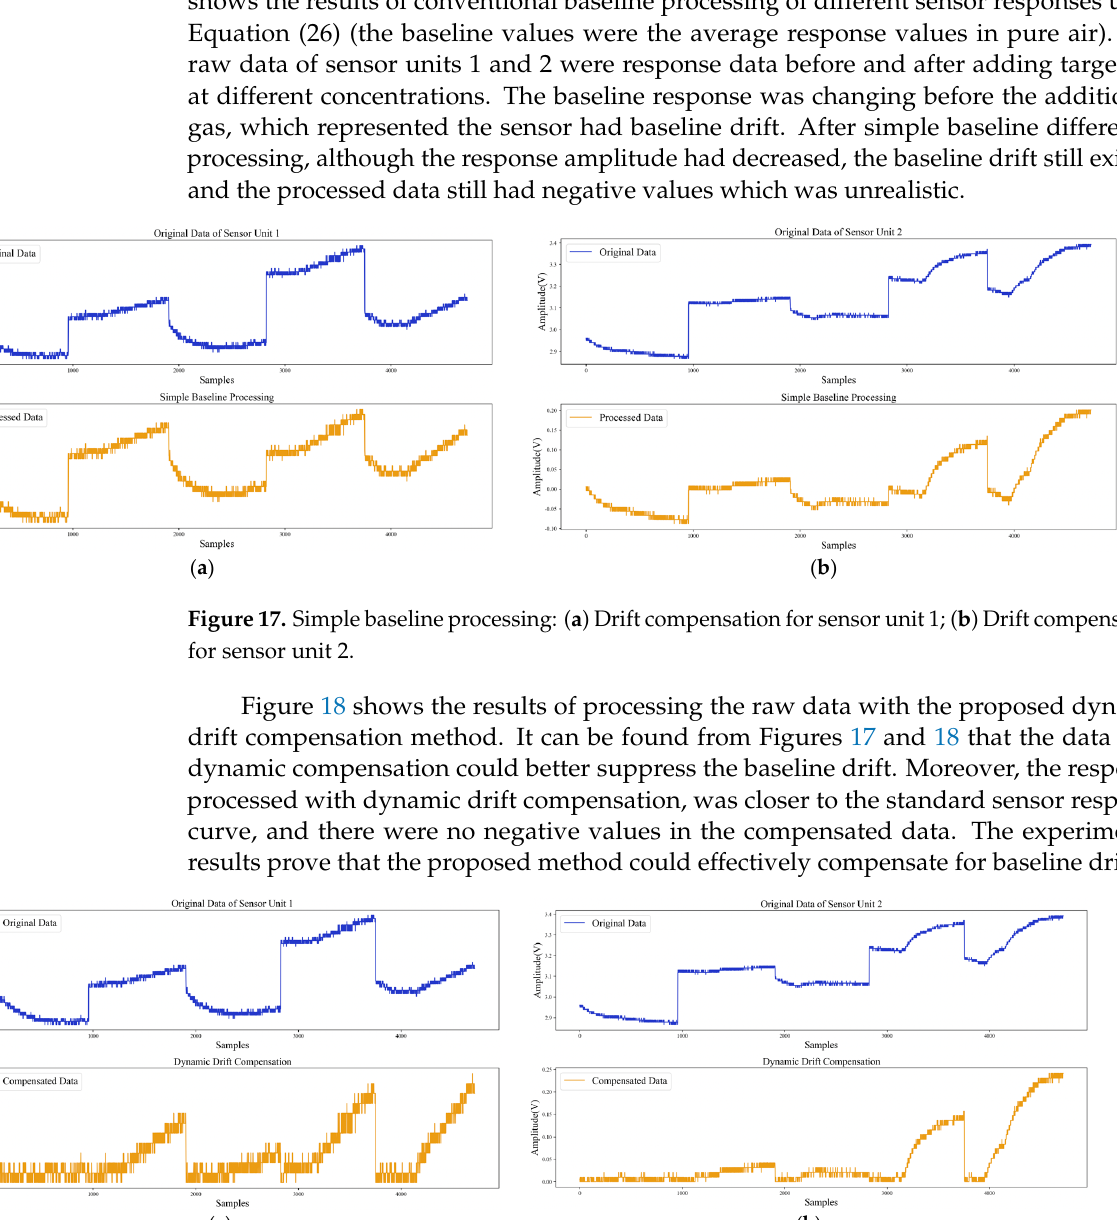
Table 11. Comparison of multi-faults computation time and model size.